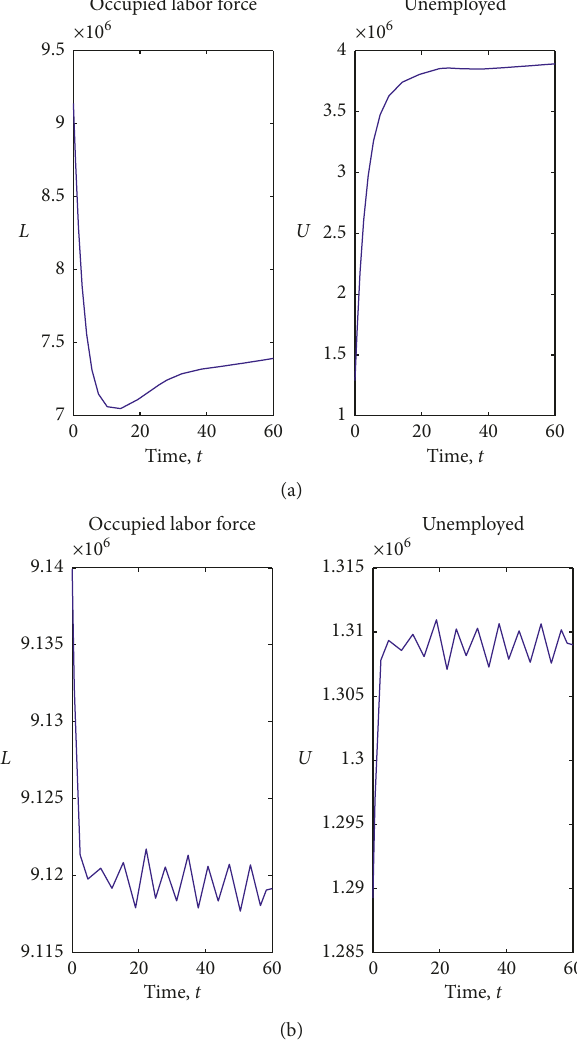
Figure 2: Examples of times series obtained by numerical in- tegration of labor force evolution model